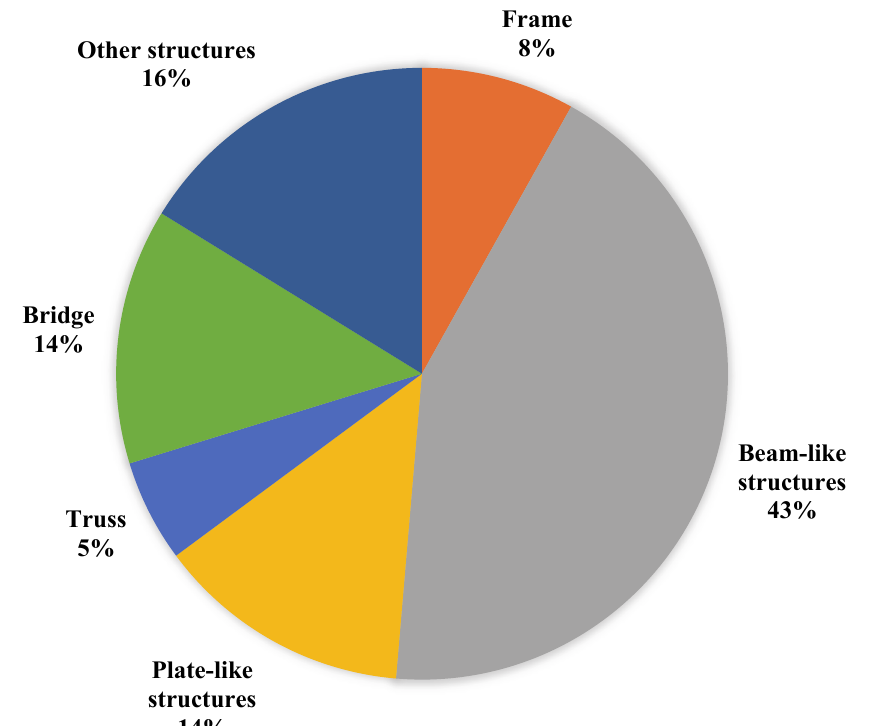
Figure 7: The allocation of employed structures to illustrate the efficiency of presented methodologies in the publications.